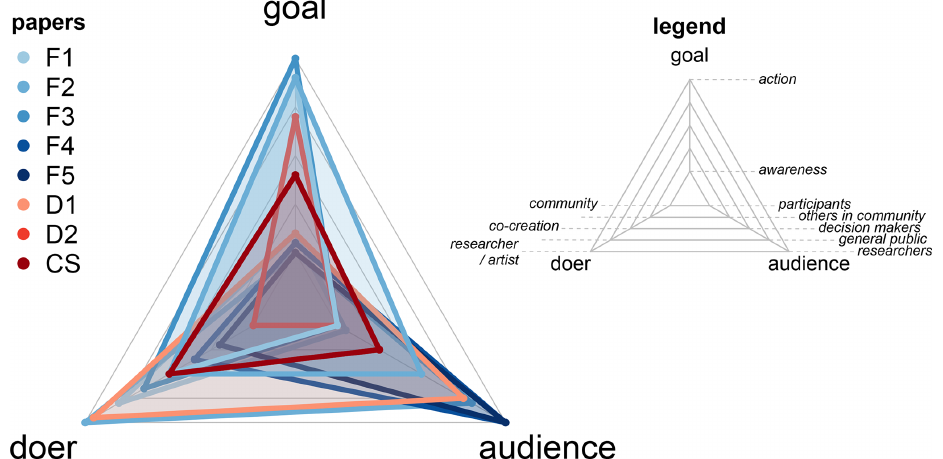
Figure 4. Papers on drought and flooding are classified into the following three categories: goal of the creative practice (“goal”), doer of the creative practice or creator of the end product (“doer”), and audience of the creative practice or the end product (“audience”). For abbreviations and paper details, see Table 1. The goal axis is gradually going from awareness close to the centre to action at the top and a combination in between. The doer axis has community close to the centre, artist and researcher at the lower left end and co-creation in between. The audience axis has five points on the axis, namely participants, others in the community, decision makers, general public, and researchers. All papers have different colours; the drought papers and case study are shown in red, and the flood papers are shown in blue. The location of the papers on these axes is not accurate but a best